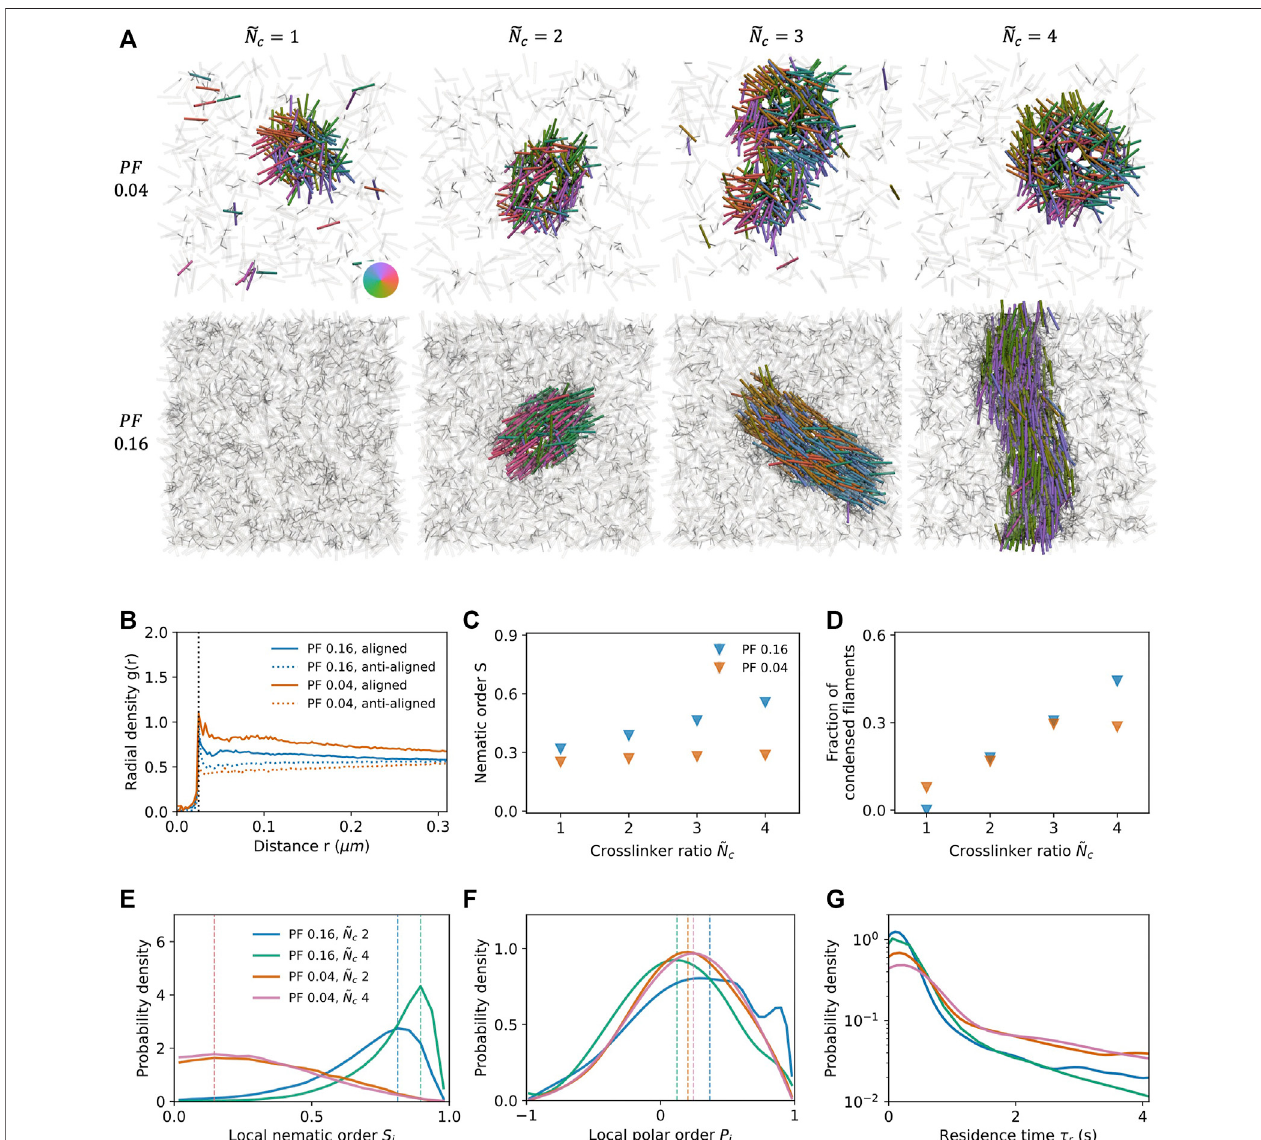
FIGURE 4 | Condensate formation in the presence of non-end-pausing crosslinking motor proteins under planar con fi nement with surface separation H = L . (A) Simulationsnapshotsatpackingfraction ϕ =0.04(toprow)and0.16(bottomrow)andvaryingcrosslinkernumberratio ~ N c .Crosslinkingmotors(black)bindandwalkon fi laments(coloredaccordingtotheir XY orientation)leadingtoextensilestressgenerationduetoantiparallelslidingofanti-aligned fi lamentpairs.At ϕ =0.04,motoractivity leads to formation of condensates with low orientational order. At ϕ = 0.16, no condensation is observed for ~ N c (cid:2) 1, but increasing ~ N c leads to condensation into bundles of increasing length and with a high degree of orientational order. (B) Center-of-mass radial distribution functions g ( r ) for aligned and anti-aligned fi laments. For both ϕ = 0.04 (orange) and 0.16 (blue), the density of aligned fi laments (solid lines) is greater than the density of anti-aligned fi laments (dotted lines) for small pair separations( r < 0.3 μ m),evidenceforpolaritysorting. (C) Theglobalnematicorderparameter S forthesystemisindependentof ~ N c for ϕ =0.04butincreaseslinearlywith ~ N ϕ =0.16. (D) Thefractionofcondensed fi lamentsincreaseslinearlywith ~ N ϕ .However,for ϕ =0.04,thecondensedfractionplateausat~ 0 . 3. (E) c for c forbothvaluesof Probability density of the local nematic order parameter S i within the condensate. For ϕ = 0.16, condensed fi laments have a high degree of local orientational order, evidenced by peaks at values greater than 0.8. (F) Probability density of the local polar order parameter P i for all condensed fi laments i . The presence of peaks in the density at positive values of P i is evidence of polarity sorting. (G) Residence time τ R for fi laments within condensates. Filaments experience random directed motion in condensates with low ϕ and low orientational order, which leads to an increased residence time. For ϕ = 0.16, fi laments experience coherent directed motion which is more ef fi cient at ejecting them from the condensate. Note: C-D show mean values averaged over 10 s of a single simulation and error bars show standard deviation. Where not visible, errors are too